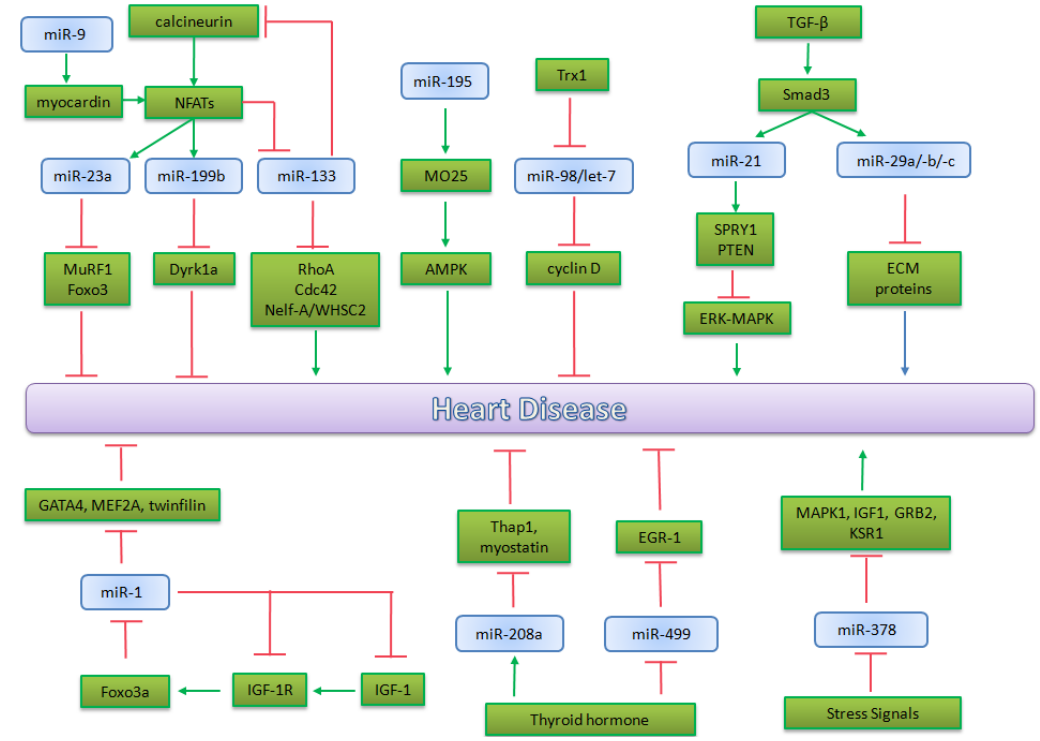
Figure 3. miRNAs involved in Heart Pathophysiology. A schematic overview of the relevant microRNAs implicated in principal heart disease ( i.e ., cardiac hypertrophy, heart failure and